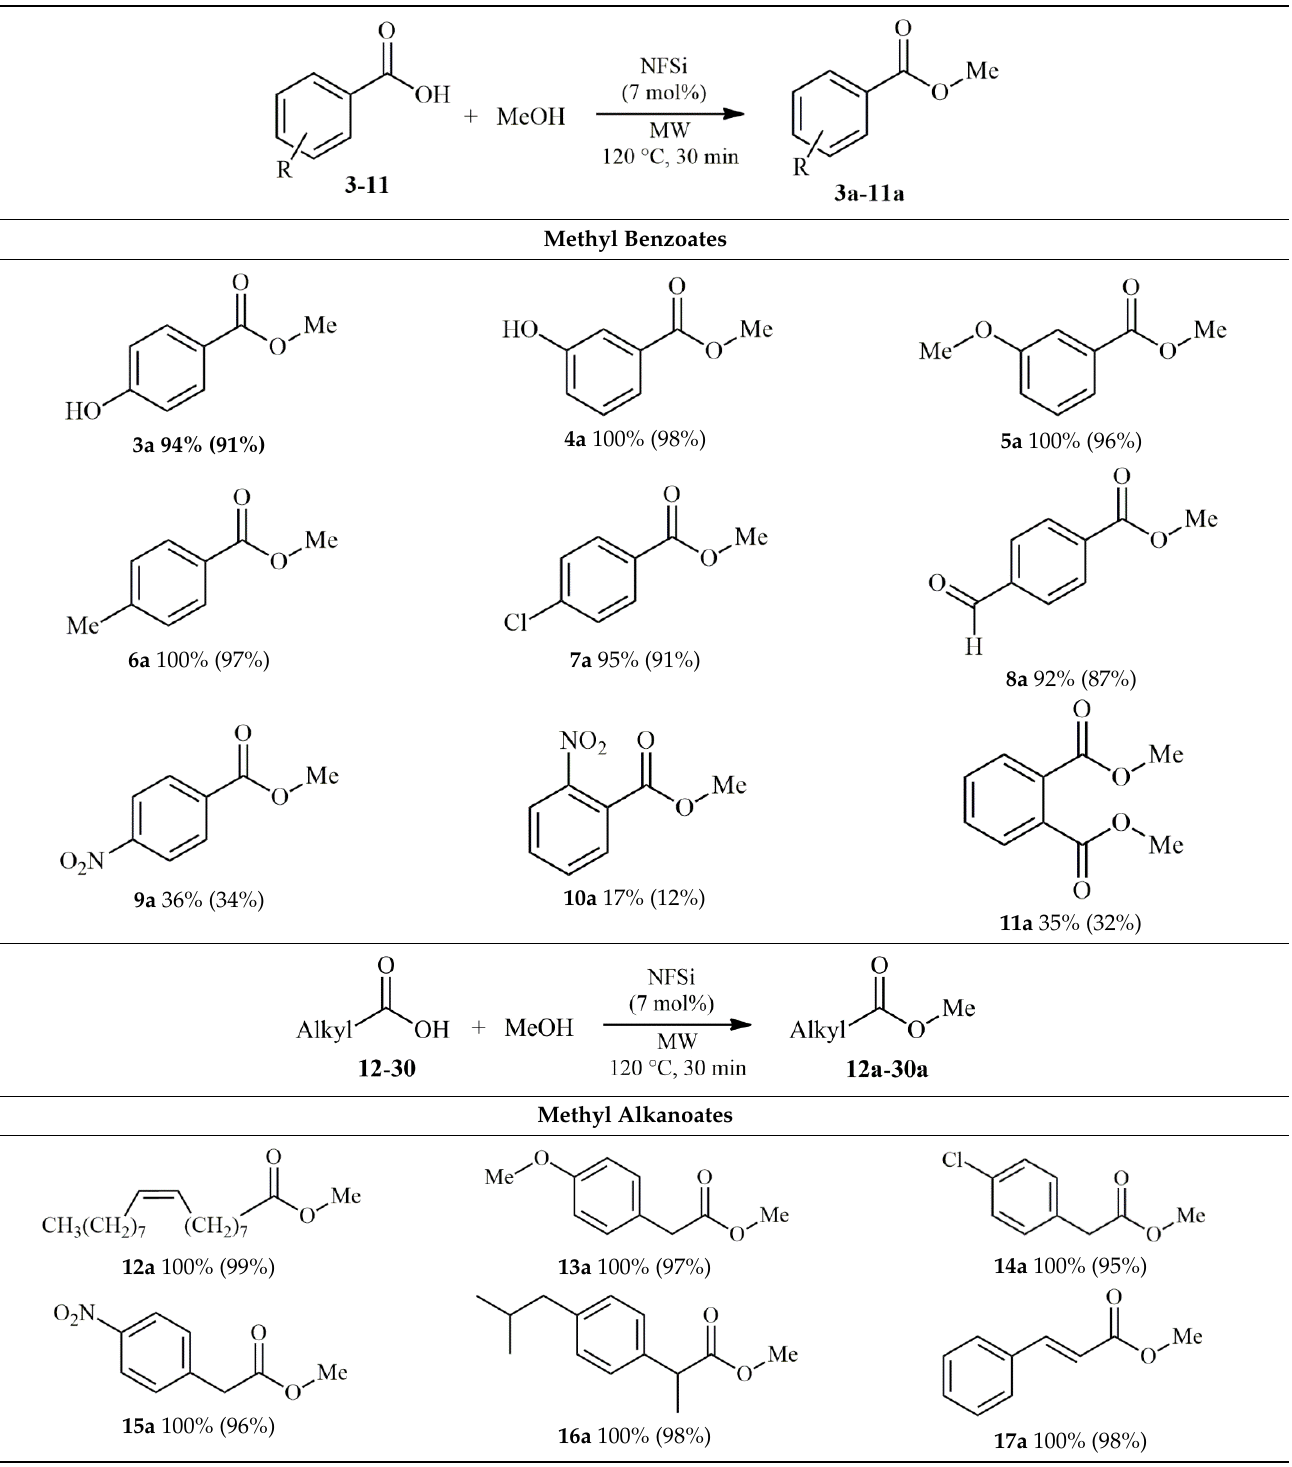
Table 3. Esterification of substituted benzoic and different alkyl carboxylic acids with MeOH under previously defined optimal reaction conditions for benzoic acid ( 1 ).